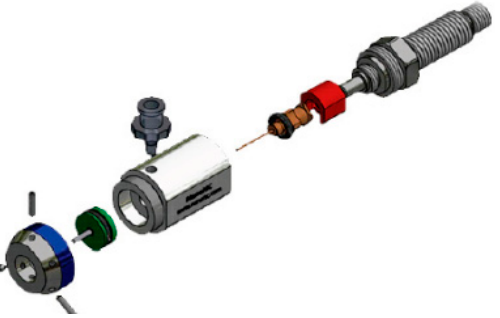
Figure 3. Exploded view of the coaxial nozzle, reprinted from NanoNC Ltd. Table 1. The coaxial PBLG/PVDF microfiber fabrication procedure.